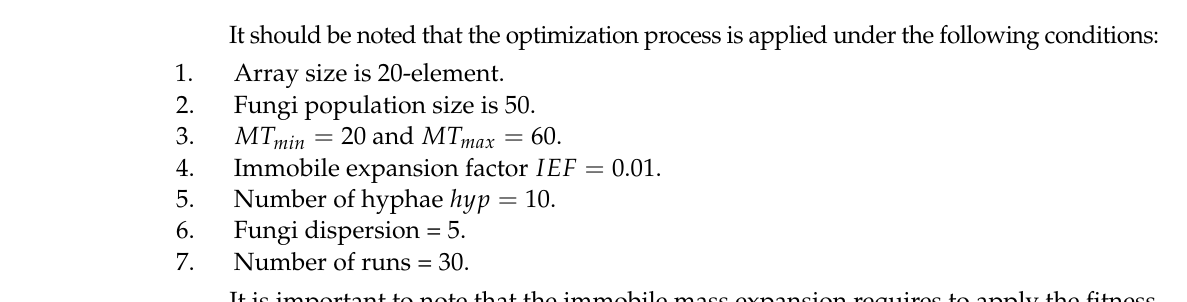
Figure 2. Antenna array ( a ) structure and ( b ) the array factor in dB.